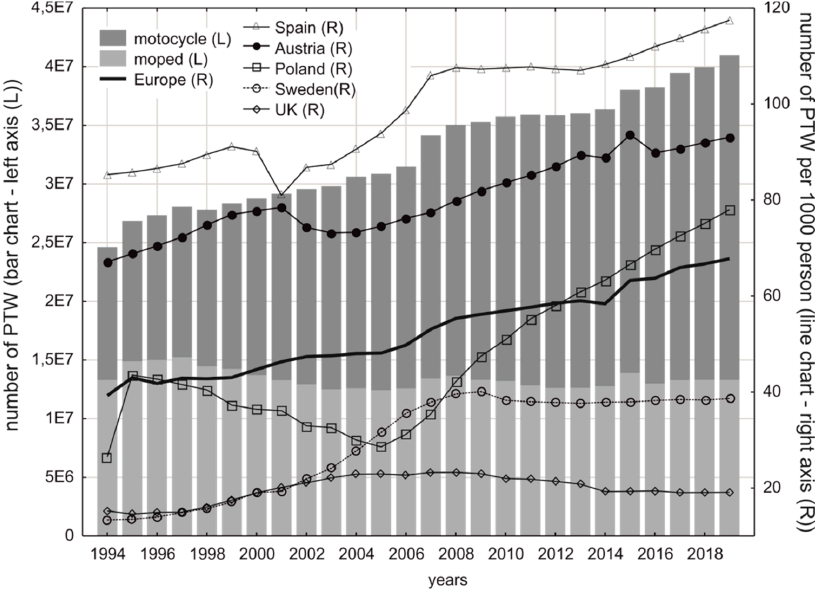
Figure 1. The number of PTW vehicles in Europe and numer of PTW calculated per numer of inhabitants in selected European countries in the years 1994–2019. Author: S. Dorocki.